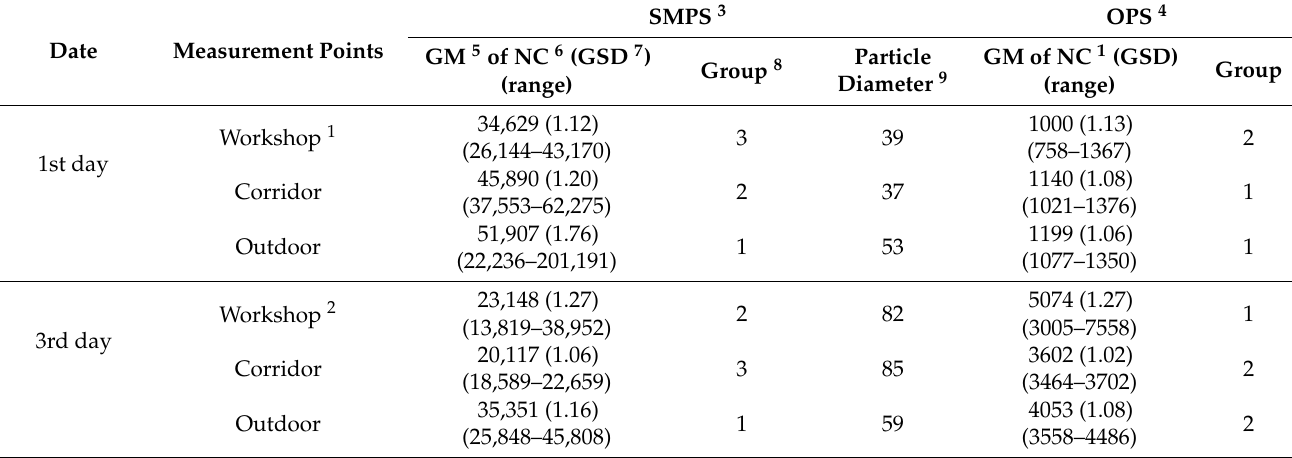
Table 3. Particle number concentration, and diameter using Scanning Mobility Particle Sizer, and Optical Particle Sizer by sampling positions.